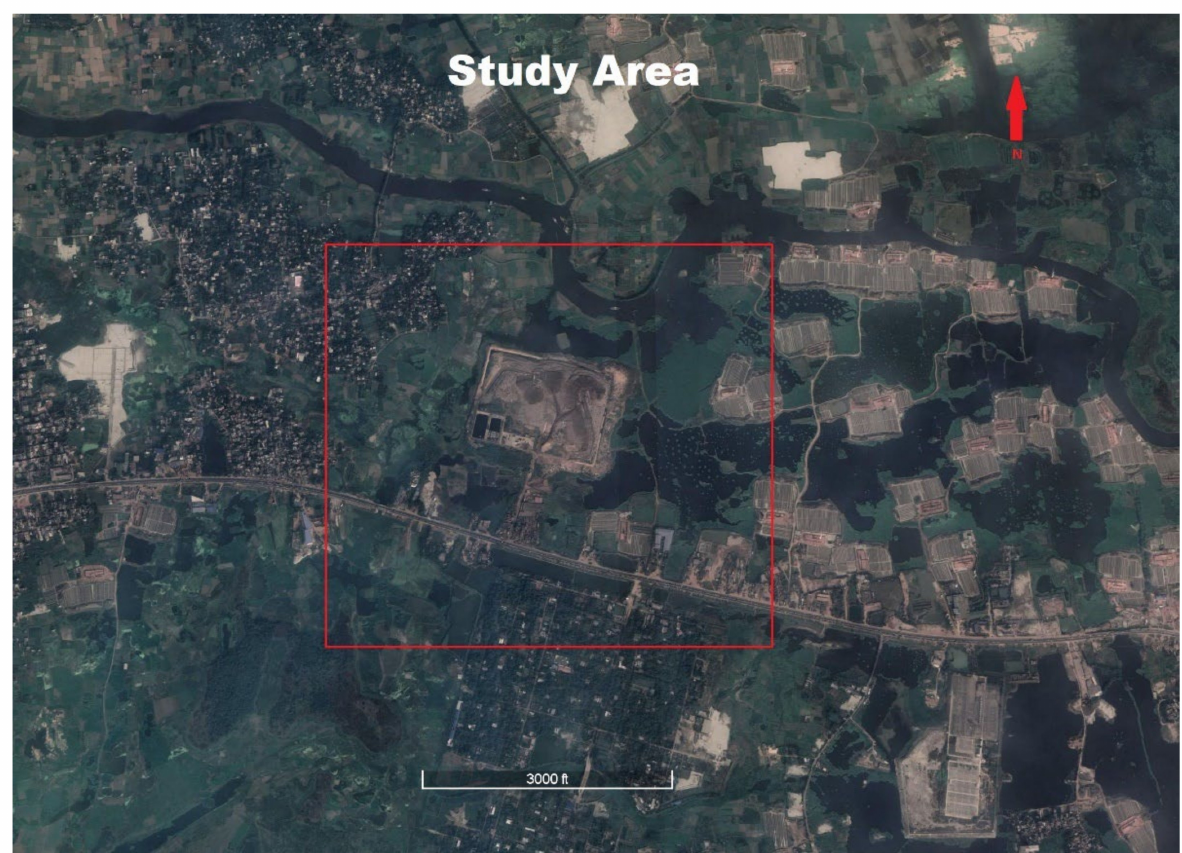
Figure 1. Satellite map of the study